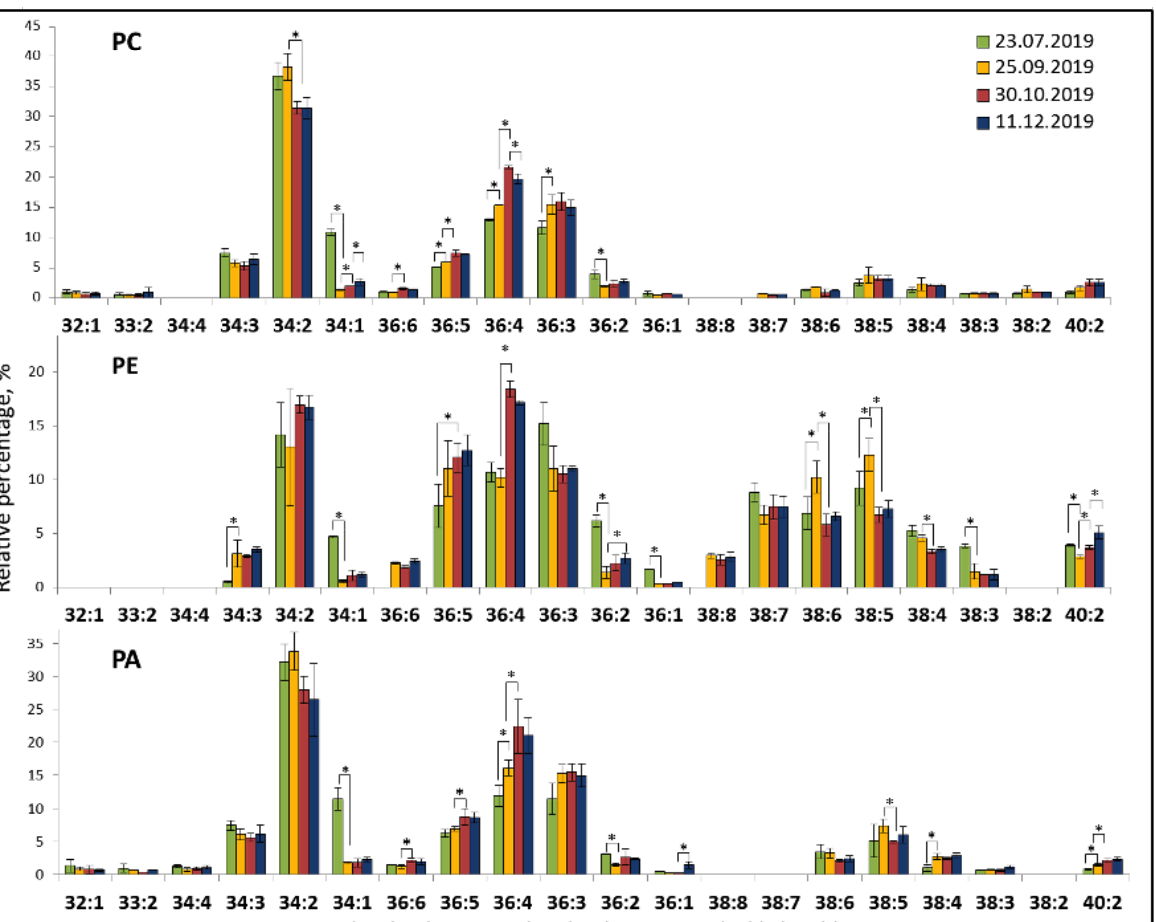
Figure 3. Seasonal changes in extraplastidic lipid molecular species in Ephedra monosperma. PC — phosphatidylcholines; PE — phosphatidylethanolamines; PA — phosphatidic acids. Bars represents standard deviations. *—significant differences according to Student’s t -test. Table 3. Double-bond index (DBI) of membrane lipids of Ephedra monosperma.